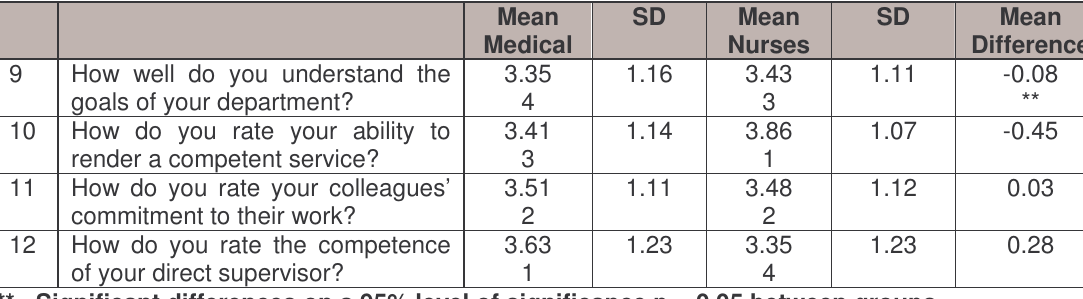
Table 3: Capability to perform (Average mean 3.502)